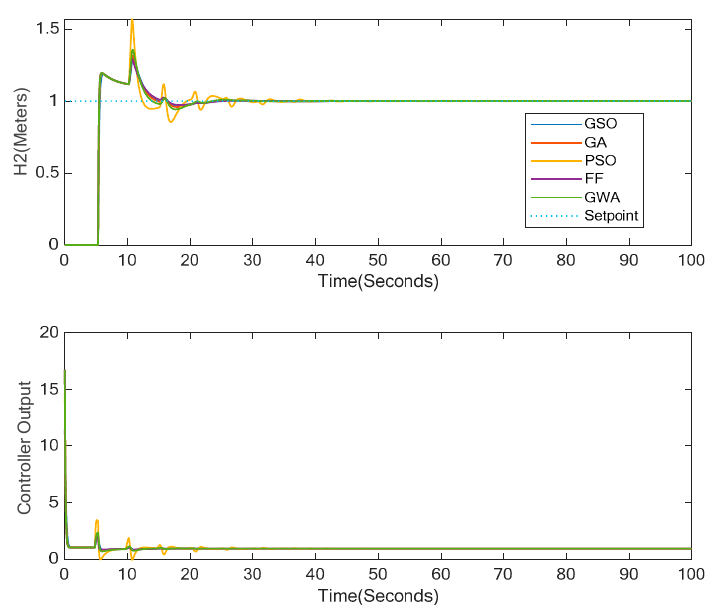
Figure 13. Example 1: Servo response with the RTD-A controller with uncertainty using optimization algorithms.